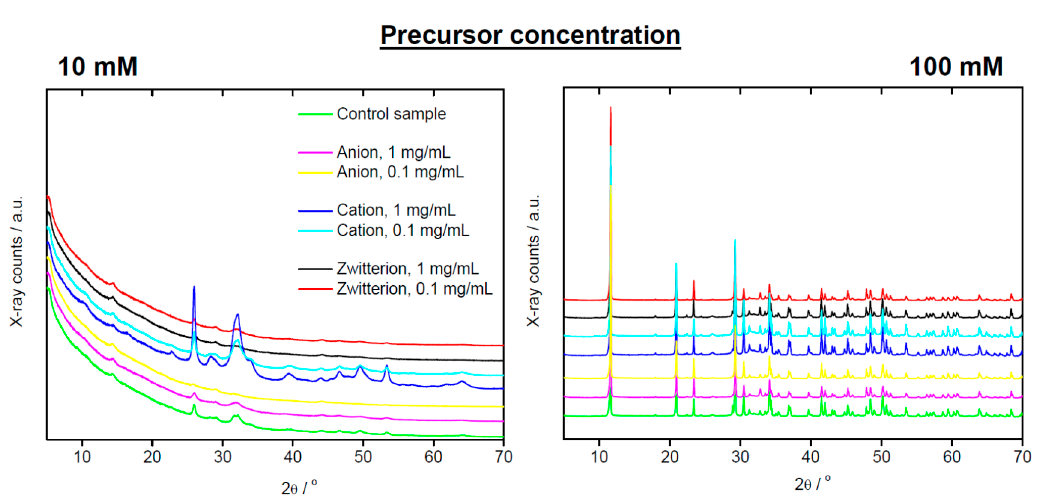
Figure 2. Representative XRD patterns of all samples studied. Control sample refers to samples grown in the absence of polymer additive. “Precursor concentration” refers to concentrations of the precursor salts (calcium nitrate and diammonium hydrogen phosphate) in the reaction mixtures. Color scheme applies to both panels of the figure. The different background in the two datasets is due to different sample holders (see experimental section for details). The difference in the signal intensities in the left panel are due to different amounts of material used for XRD analysis; this stems from the fact that these reactions in general provide very little material. The more intense reflections in the right panel are due to the fact that (i) more material was obtained in these reactions and (ii) the brushite reflections are generally sharper and more intense than the apatite or OCP reflections; this is due to a higher order (less defects) in brushite compared to HAP or OCP.